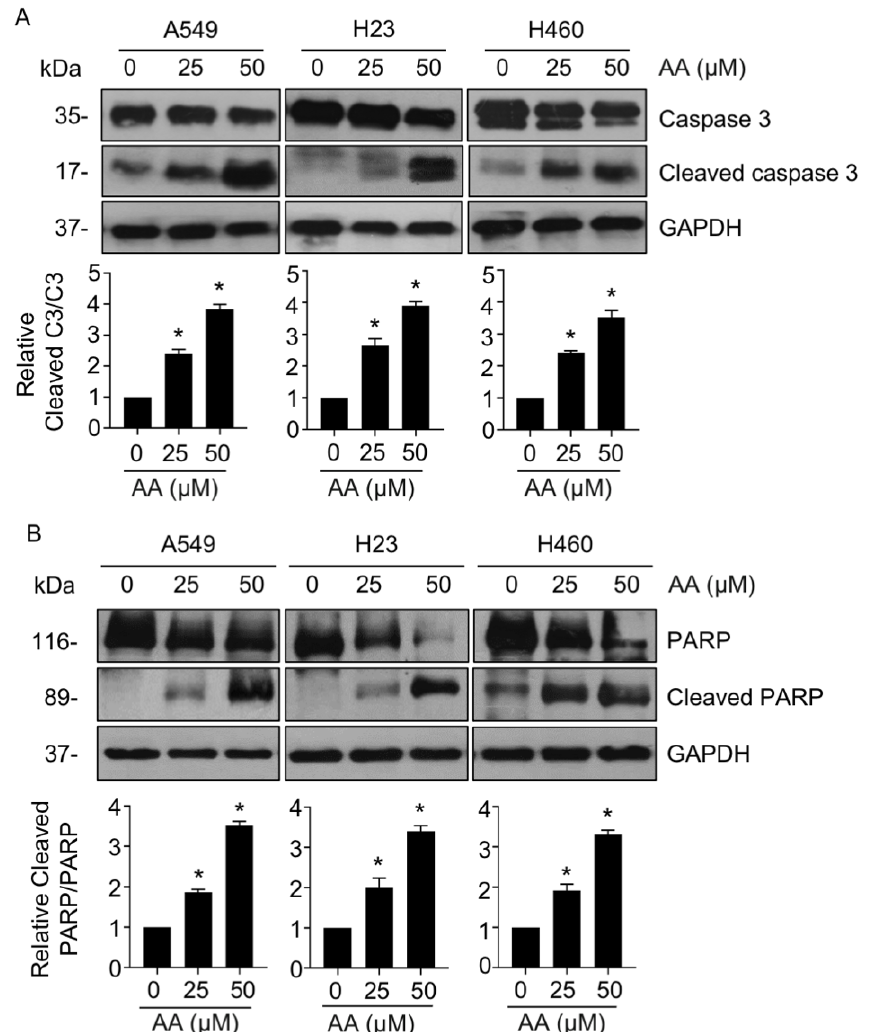
Figure 2. Aspiletrein A (AA) mediated cleavage of caspase-3 and poly-ADP-ribose polymerase (PARP). Lung cancer cells were treated with AA (0–50 μM) for 24 h. Protein levels of ( A ) caspase 3/cleaved caspase 3 and ( B ) PARP/cleaved PARP were analyzed using Western blotting. Blots were re-probed with anti-GAPDH to confirm equal loading. Protein level was quantified and presented as a relative value to the control. Data are mean ± SEM ( n = 4). * p < 0.05 vs. control cells.